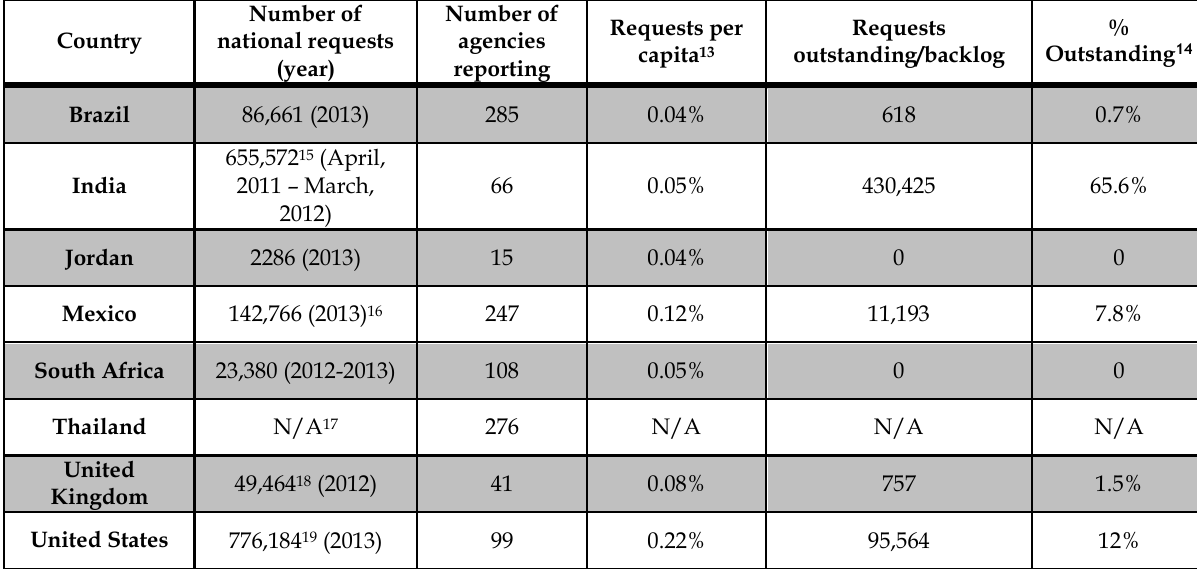
Table 2: Request Volume